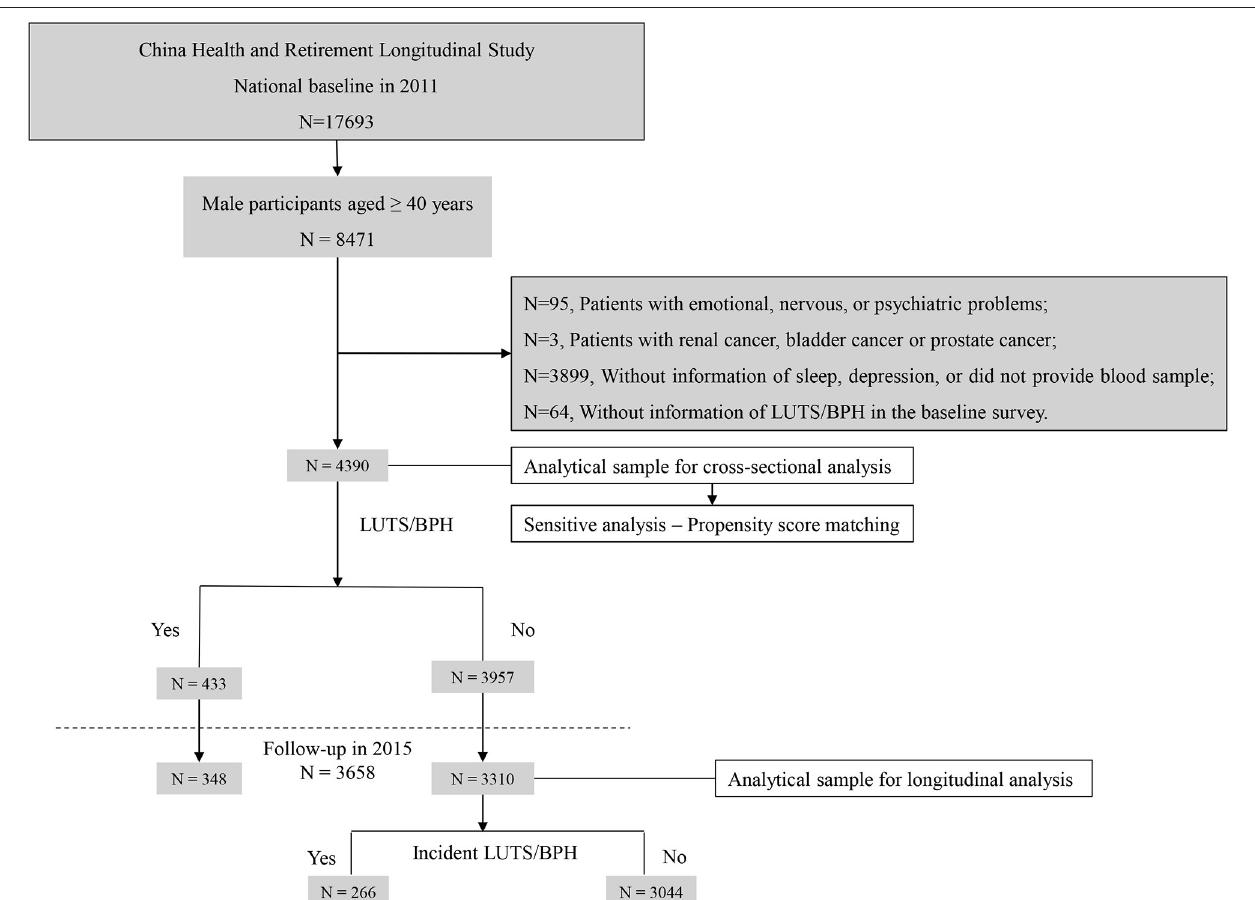
FIGURE 1 | Sample flow chart. N, number; LUTS/BPH, lower urinary tract symptoms suggestive of benign prostate